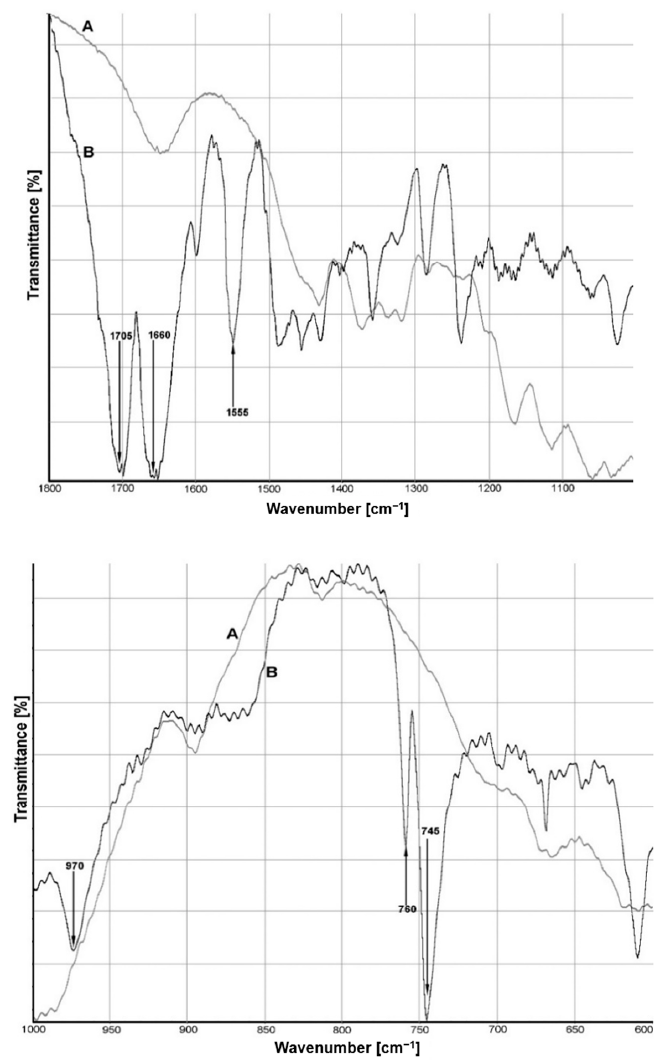
Figure 2. Fourier transform infrared (FTIR) spectra of cellulose fiber (A) and the mixture of cellulose with caffeine (B) at the 1800 to 1000 cm − 1 range, and at the 1000 to 500 cm − 1 range. The two peaks between 2950 cm − 1 and 2850 cm − 1 are associated with the asymmetric and symmetric C − H methyl and methylene stretching groups present in the spectra for cellulose in Figure A2. The bands at 1665–1645 cm − 1 in the cellulose spectrum have been reported to be a hydrogen bonding coupled with COO¯ of the cellulose [40]. The vibra- tions at around 1600 cm − 1 and 1555 cm − 1 have a high pyramidic character in caffeine and decreases the stretching vibrations ( ʋ) of the C=C and C=N bond. The vibrations of the ʋ (C=N) band in the imidazole structure are also observed at 1490 cm − 1 . The spectrum re- gion from 1455 cm − 1 to 1405 cm − 1 represents the C − H and C=C bond vibrations derived from the caffeine molecule. The band at 1375 cm − 1 originates from the deformations of the